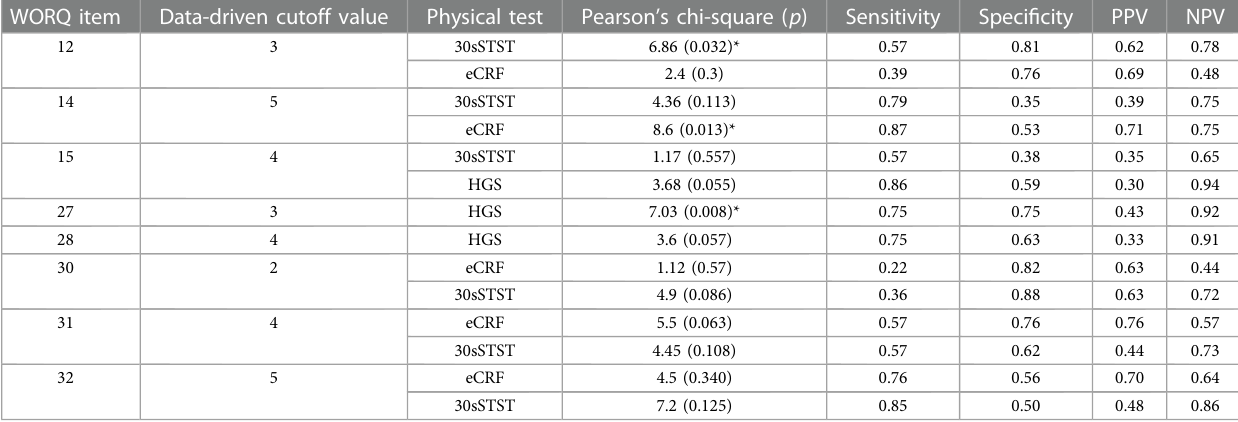
TABLE 5 Chi-square tests and calculations of sensitivity, speci fi city, positive predictive values (PPVs), and negative predictive values (NPVs) based on cross tabulations on categorized WORQ items and the results of the physical capacity tests, n =40. WORQ